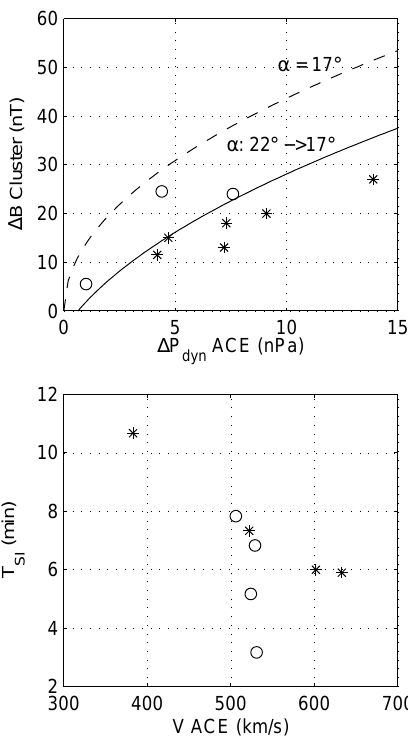
Fig. 8. Changes in the solar wind dynamic pressure at ACE com- pared to the corresponding tail lobe SI amplitude at Cluster. The cir- cles show the events during which Cluster was closest to the Earth ( ∼ 10 R E ). For the dynamic pressure upstream of the shock the value of 1 nPa has been used ( a ) . The propagation speed of the shock or solar wind speed compared to the duration time of the tail lobe SI ( b ) .